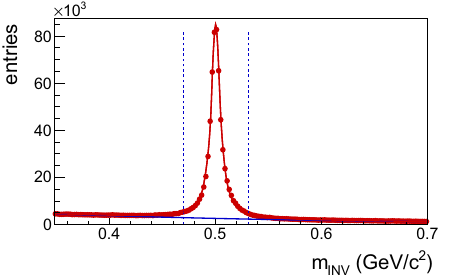
Fig. 4 Armenteros-Podolanski plots for V 0 candidates without ( left ) and with all track and topology selection criteria ( right )